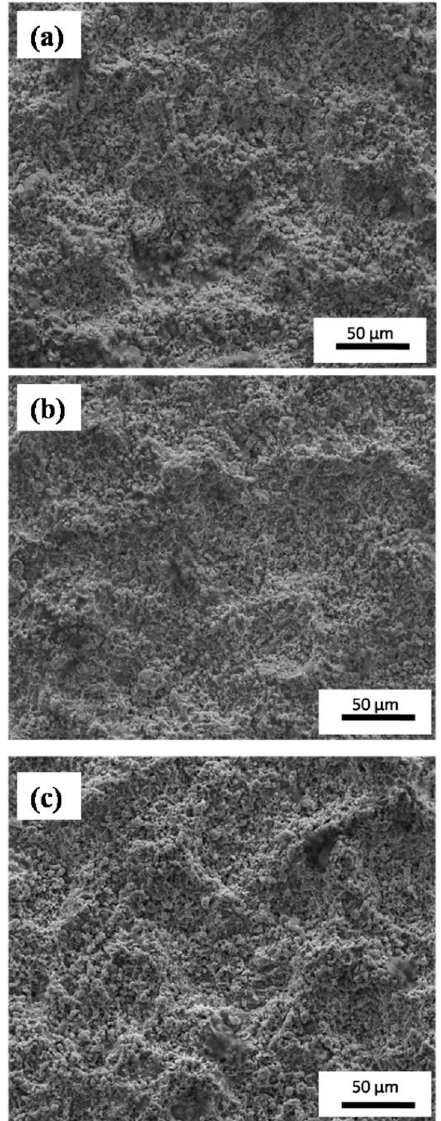
Figure 12. Surface morphology of the Cr 3 C 2 –25NiCr coating after erosion ‐ corrosion at different rotating speeds of ( a ) 3000, ( b ) 4500 and ( c ) 6000 rpm.